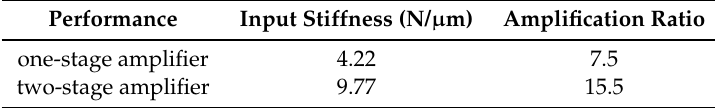
Table 3. Simulation results of two kinds of amplifiers.